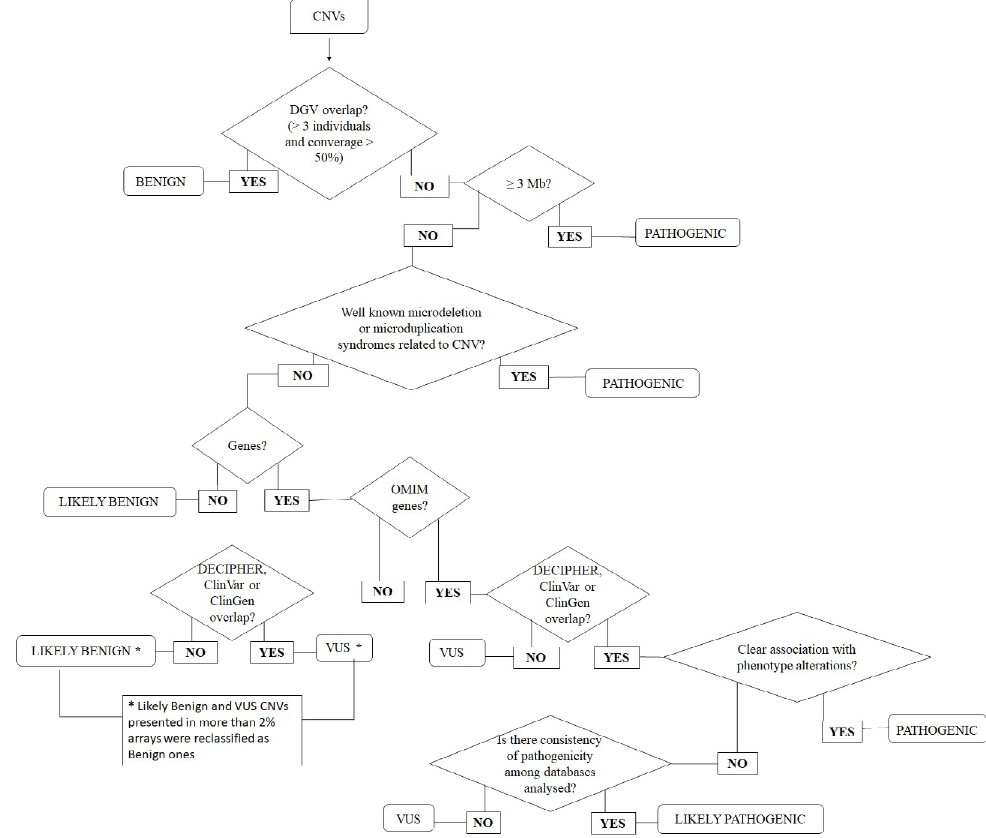
Figure 1 – Flowchart for CNVs analysis and